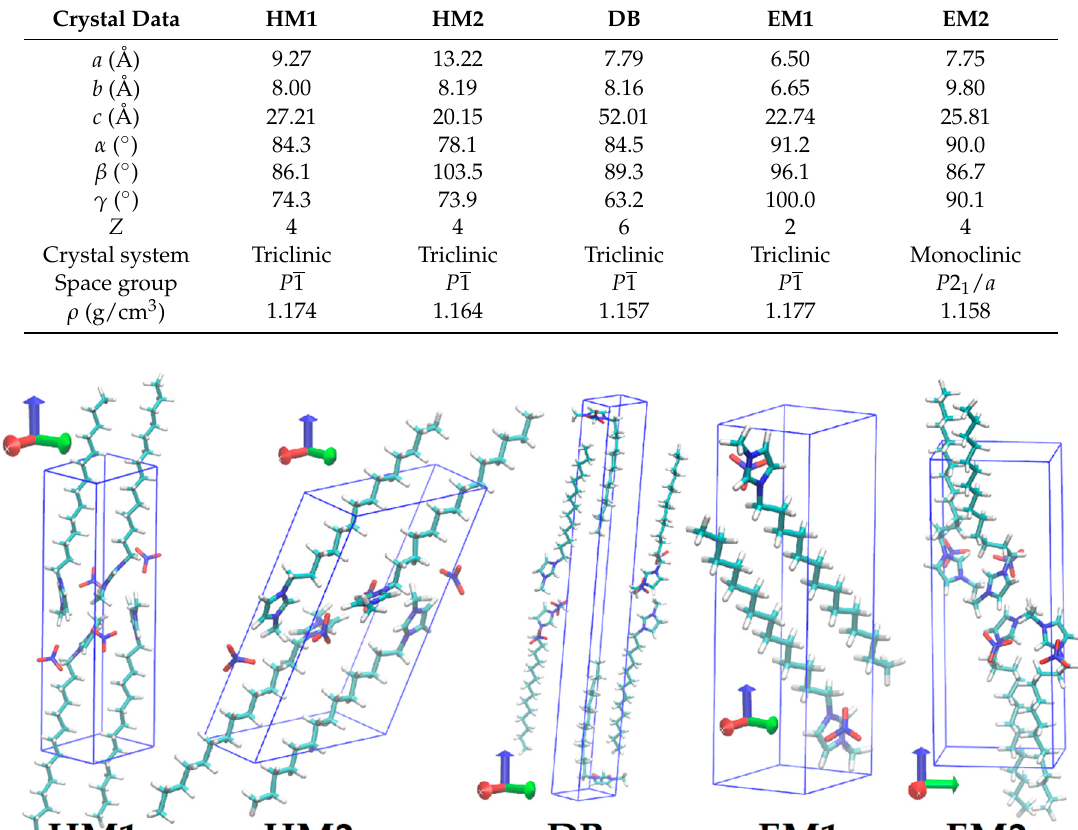
Table 1. Lattice constants of the five polymorphs at T = 200 K.